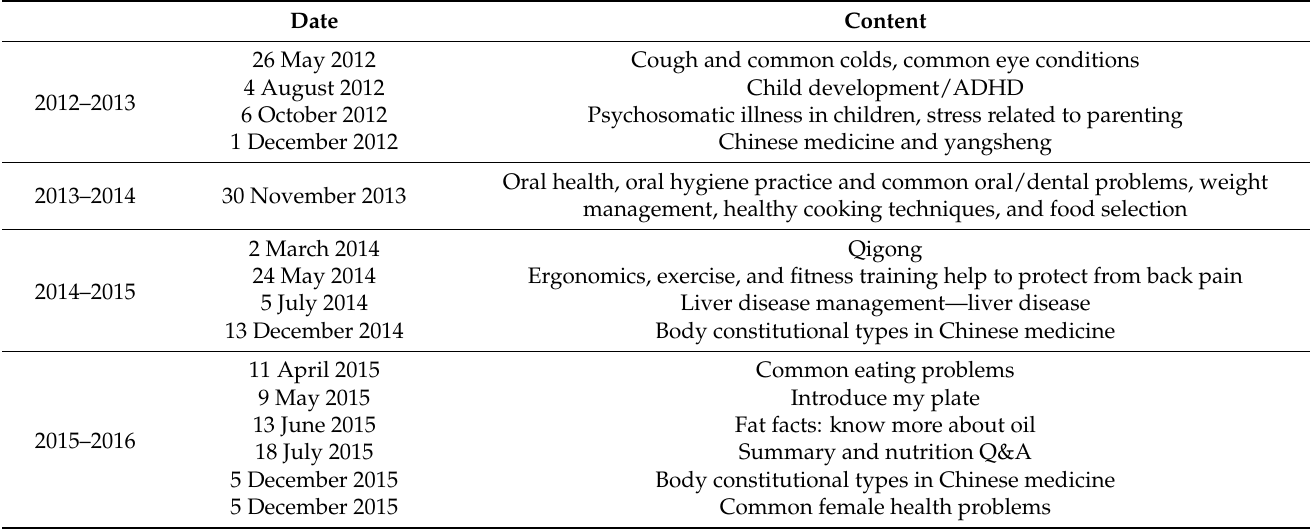
Table A1. Health literacy